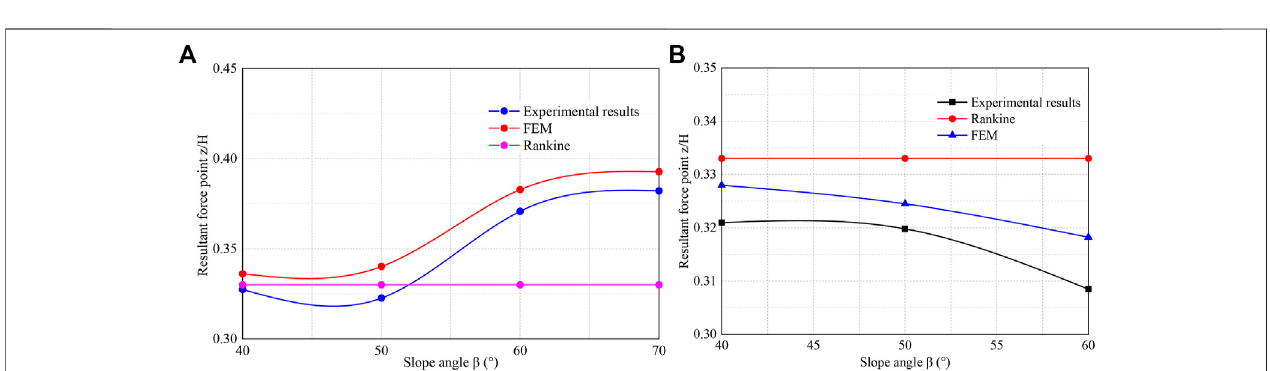
FIGURE 19 | The relationship between the resultant force point and the slope angle. (A) Tmode. (B) RBmode.